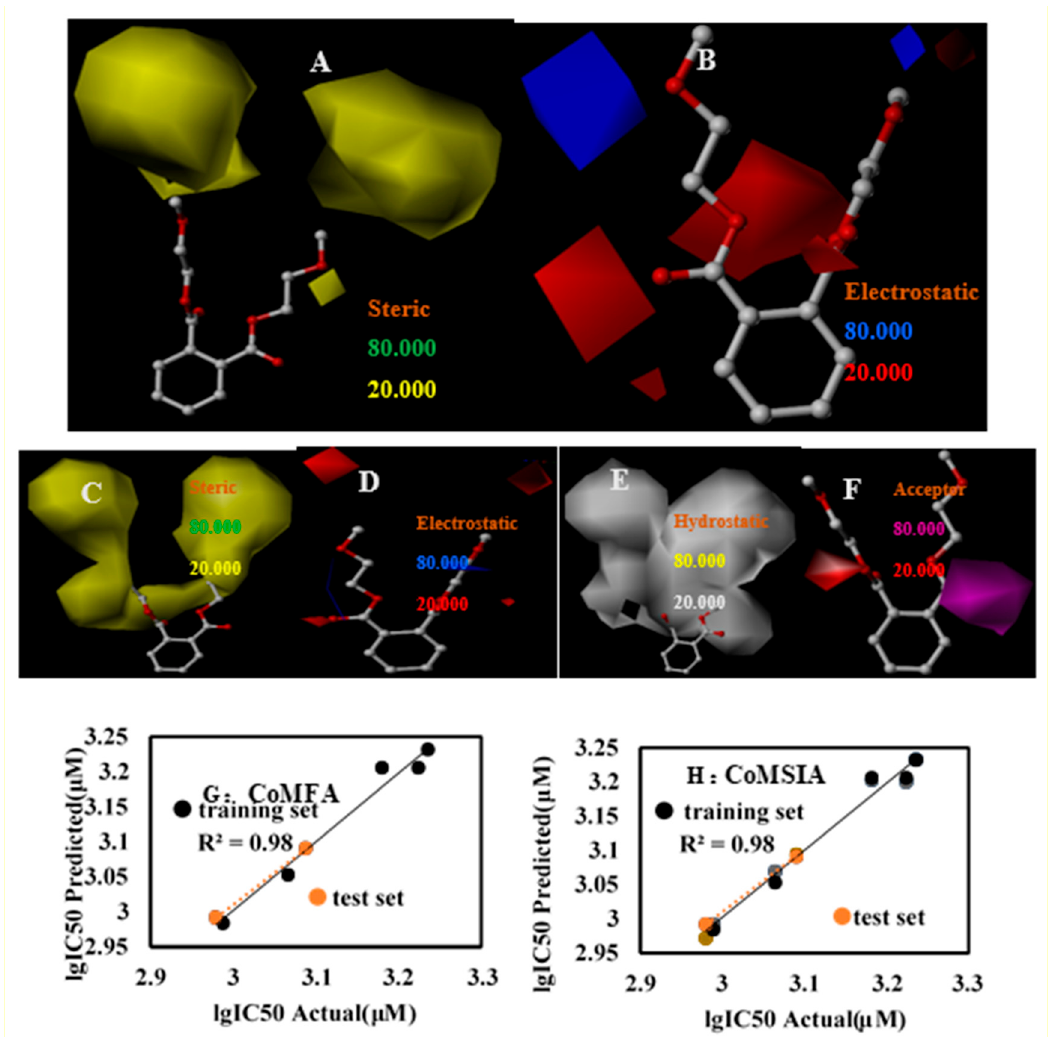
Figure 4. DMEP’s three-dimensional contour maps of steric field ( A ), the electrostatic field ( B ) in the CoMFA model and steric field ( C ), the electrostatic field ( D ), hydrophobic field ( E ), Acceptor field ( F ) in the CoMSIA model ( G ): CoMFA; ( H ): CoMSIA).